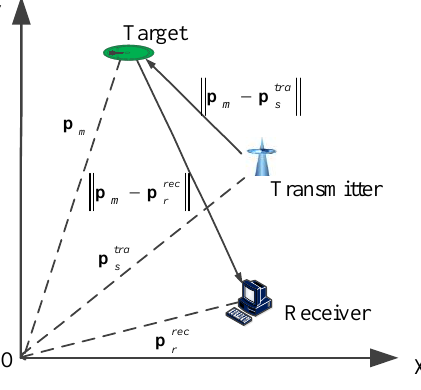
Figure 1. Target geometry for multi-target multi-sensor